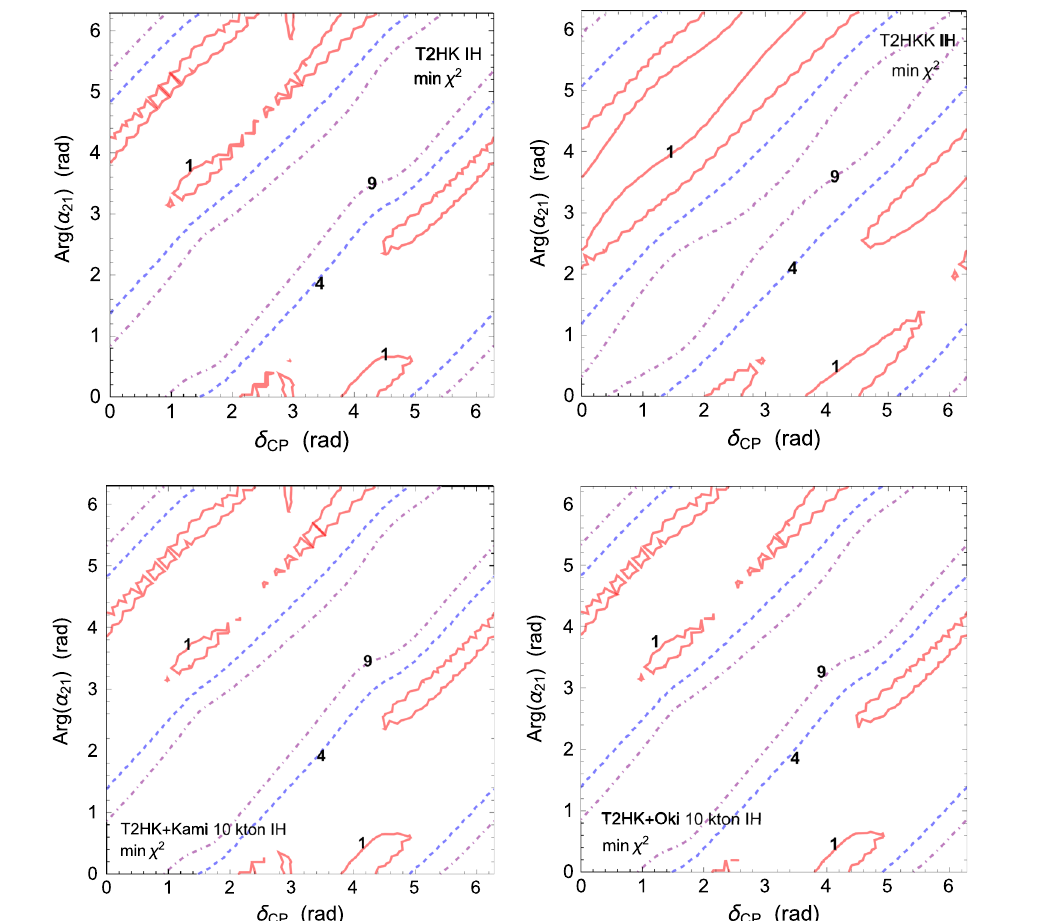
Fig. 4 The minimum of χ 2 ((cid:20)) Eq. (32), min χ 2 . The benchmark with Eq. (26) is assumed, and the true mass hierarchy is inverted. The upper- left, upper-right and lower-right subplots correspond to the T2HK, the T2HKK,andtheplanoftheT2HKplusa10ktonwaterCerenkovdetec-